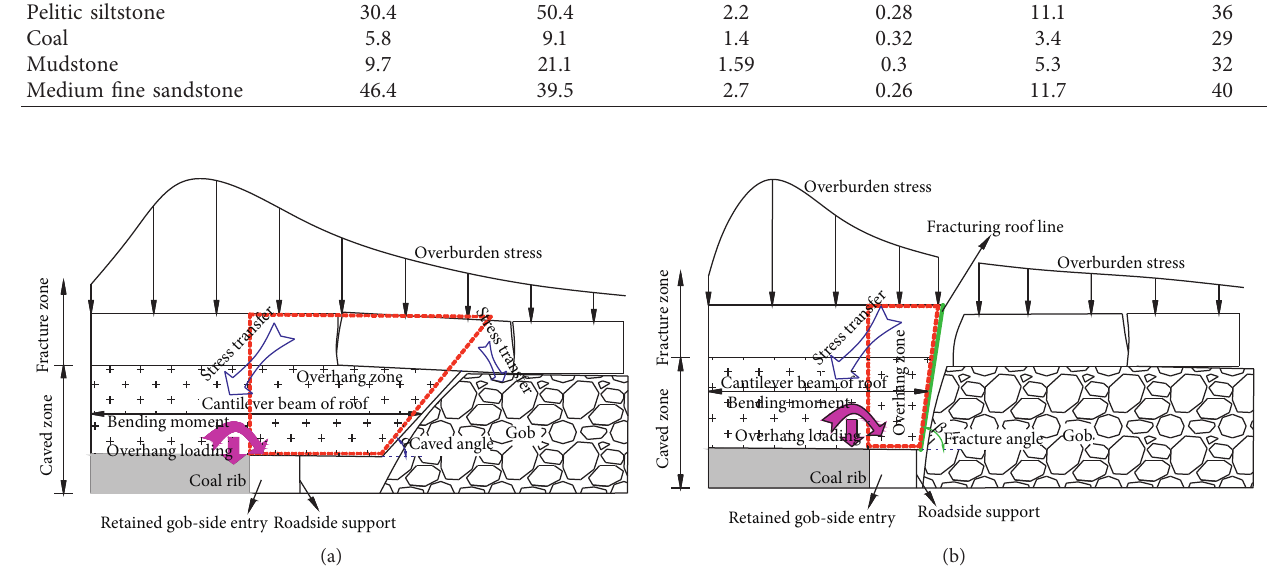
Figure 6: Surrounding rock control mechanism using BFRT. (a) Before BFRT. (b) After